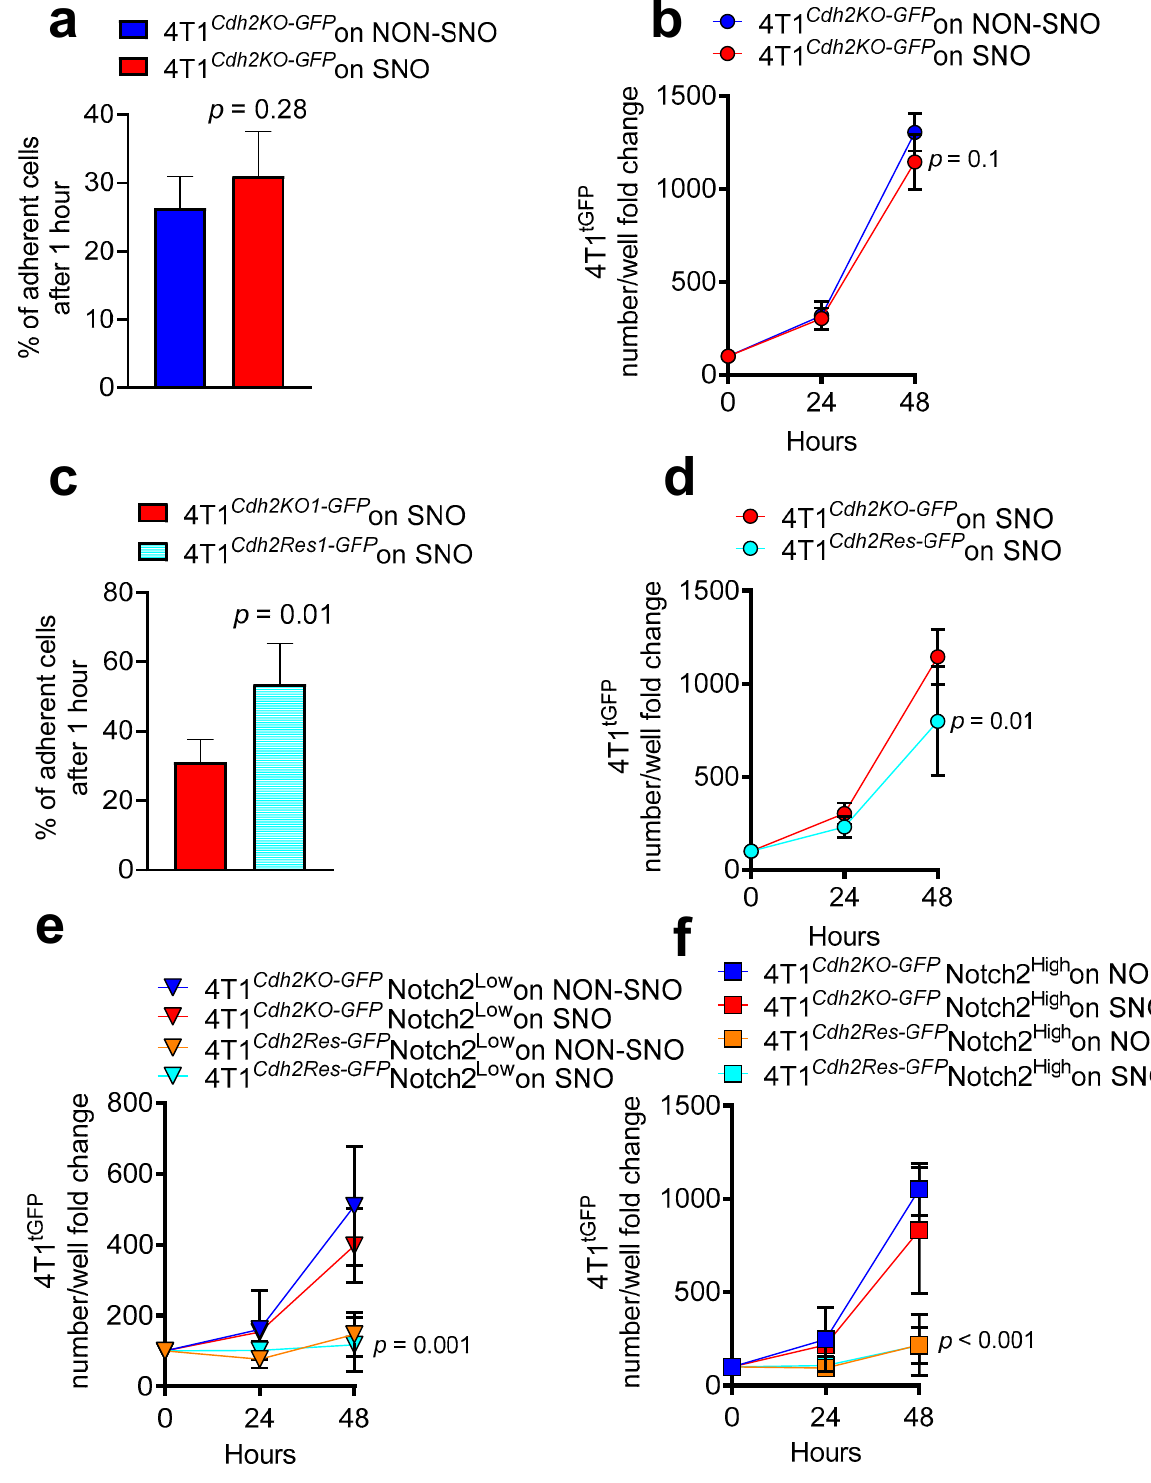
Figure 4. Role of N-Cadherin and Notch2 in 4T1-SNO interaction in vitro. ( a ) 4T1 GFP cells knocked-out for N-Cadherin expression (4T1 Cdh2-KO-GFP ) were seeded onto MACS-sorted SNOs and NON-SNOs and allowed to attach for 1 h at 37 ◦ C, followed by extensive washing. The number of 4T1 GFP cells was assessed after 1h of adhesion and ( b ) after 24–48 h of co-culture. ( c ) 4T1 GFP cells in which the N-Cadherin expression was rescued (4T1 Cdh2-Res-GFP ) were seeded onto MACS-sorted SNOs and allowed to attach for 1 h at 37 ◦ C, followed by extensive washing. The number of 4T1 GFP cells was assessed